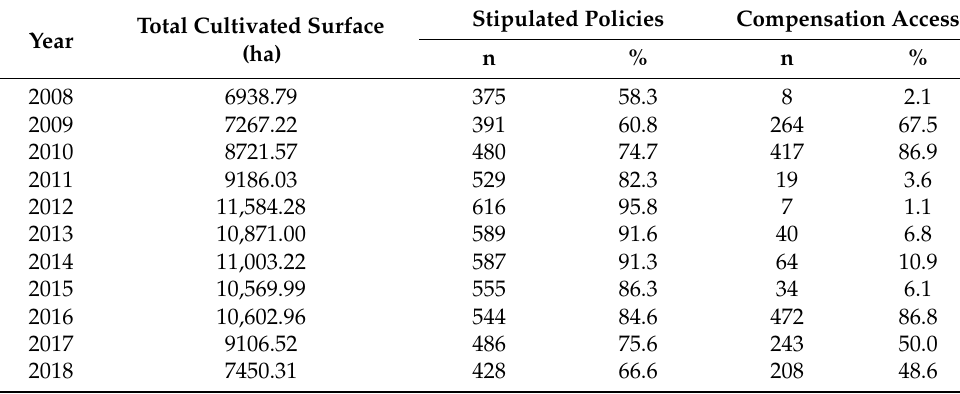
Table 3. Durum wheat: summary of revenue policy application in